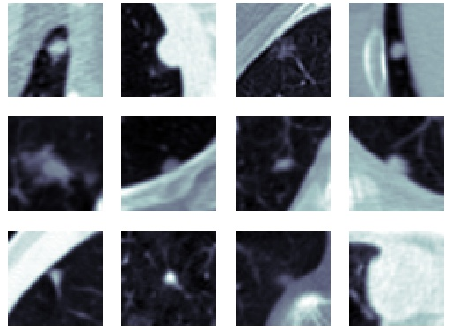
Figure 23. SFMPF model based on Trilateral image—missed nodules (FN).